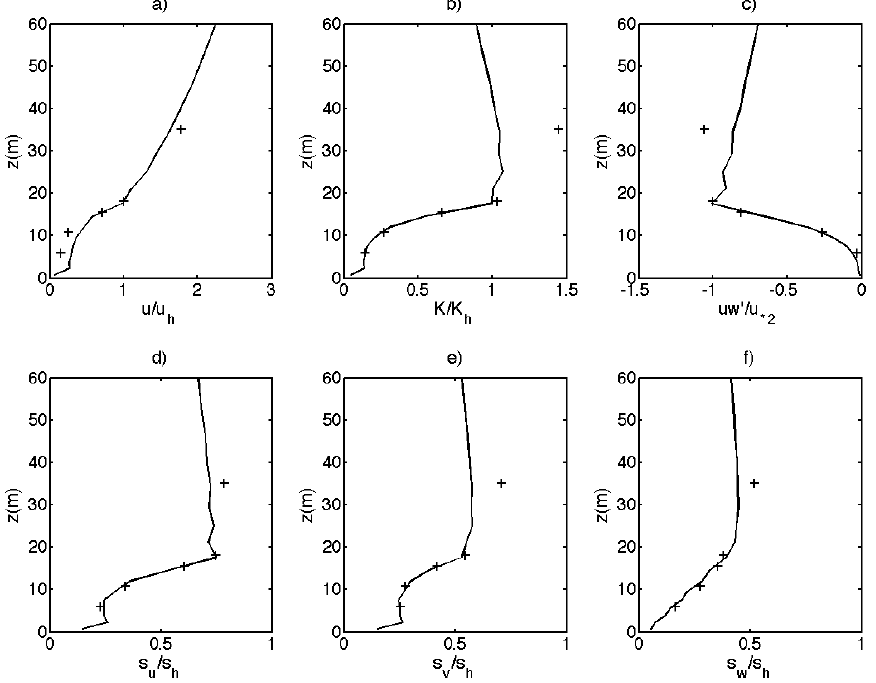
Figure A4. Simulated wind statistics over canopy Can3 with PGF4 (lines), against experimental data (+’s): ( a ) u -velocity profile; ( b ) turbulent kinetic energy; ( c ) momentum flux; ( d ) standard deviation of u -velocity; ( e ) standard deviation of v -velocity; ( f ) standard deviation of w -velocity. s h is half the square root of K h , which is turbulent kinetic energy at the canopy top.